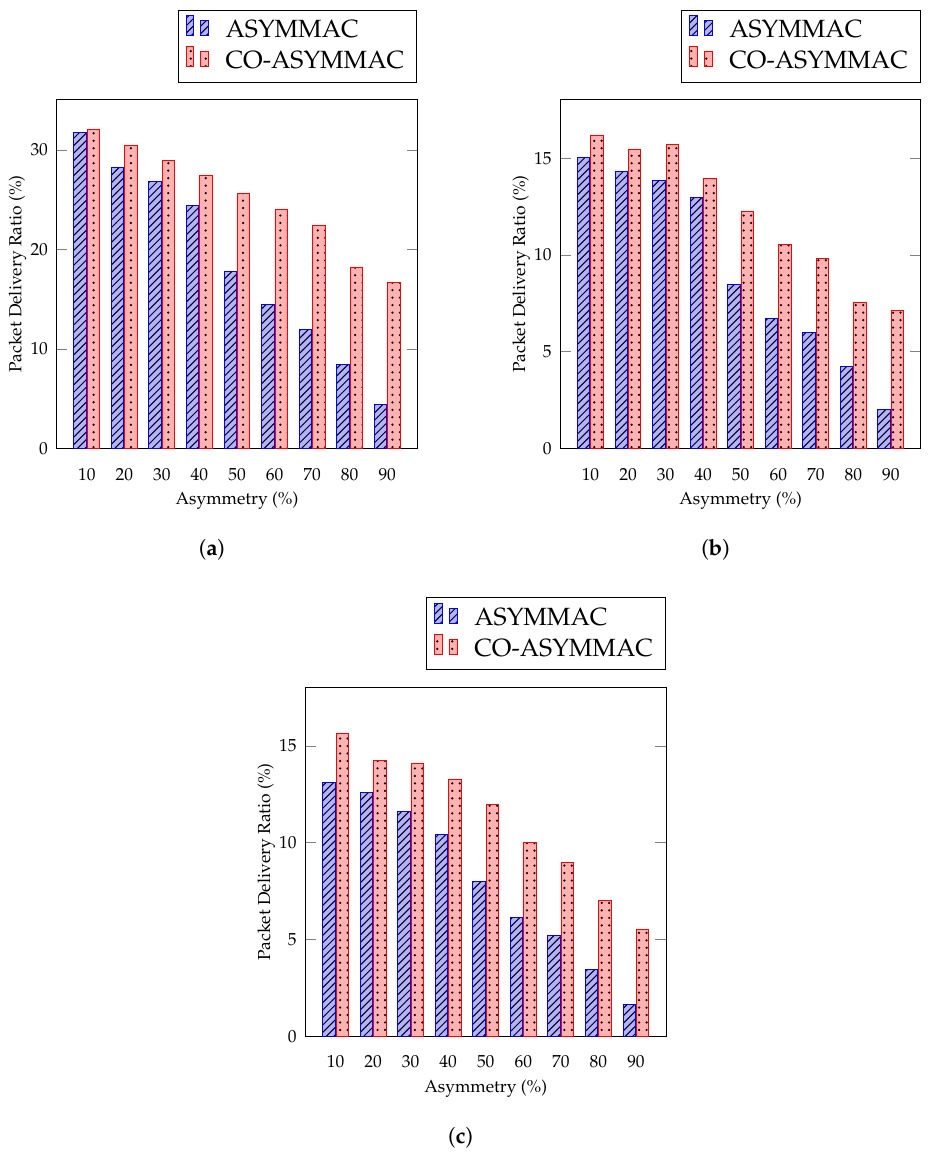
Figure 12. Packet delivery ratio: ( a ) for 27 nodes; ( b ) for 54 nodes; and ( c ) for 90